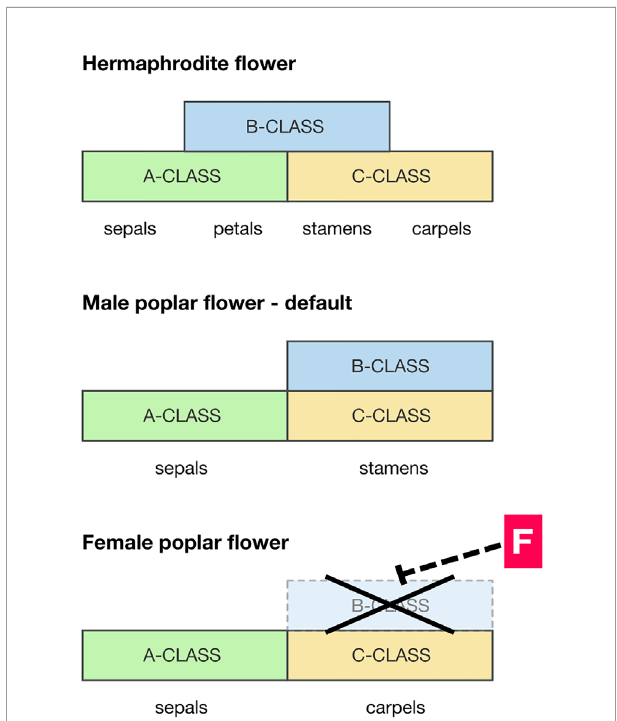
FIGURE 2 | Hypothetical scenario for the developmental pathway leading to male and female fl oral development in poplar and willow. Diagrams of the expression domains of MADS-box fl oral developmental genes relative to fl oral organ development. Top panel: pattern typical of a hermaphrodite eudicot fl ower ( e.g. Arabidopsis ), for reference. Bottom panels: suggested MADS-box gene expression domains in the formation of male and female poplar fl owers. Where the B-class MADS-box genes PISTILLATA and APETALA3 ( PI/AP3 ) are expressed, along with C-class genes, stamens develop. A wide expression domain of PI/AP3 is therefore expected in males, and this is likely to be the default in both sexes. However, in females the presence of a feminizing factor F downregulates PI/AP3 diverting development to a female developmental